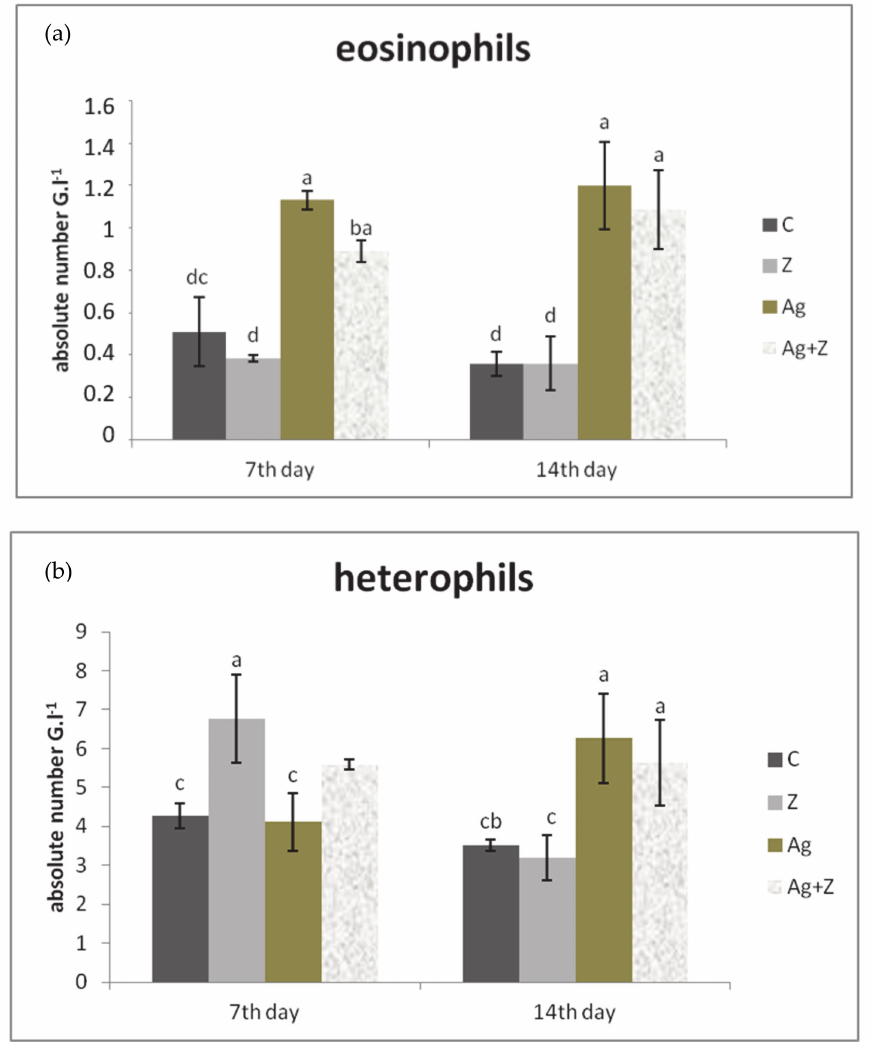
Figure 5. Effect of the administration of inorganic ZnSO 4 and infection by A. galli on the absolute number (G.l − 1 ) of ( a ) eosinophils and ( b ) heterophils in peripheral blood. Means with different superscripts are significantly different in Ag group. ab p < 0.05; ac p < 0.01; ad p <